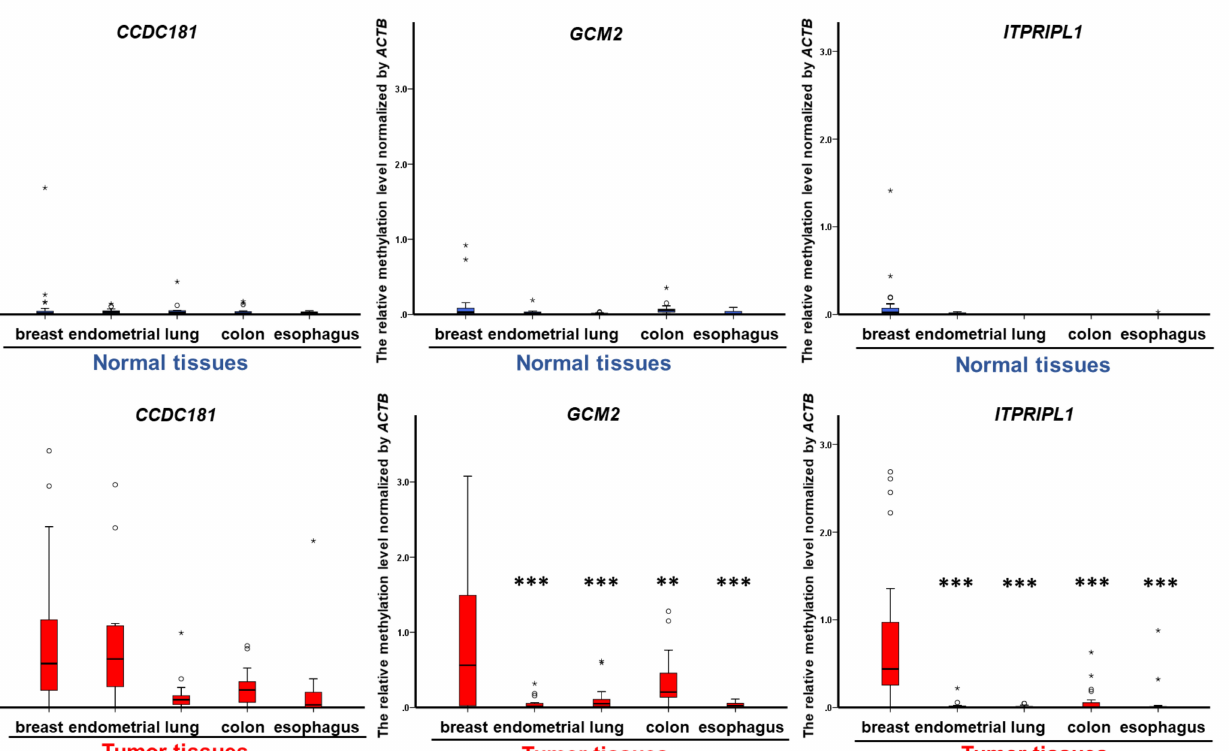
Figure 2. The boxplots for the DNA methylation levels of CCDC181 , GCM2 and ITPRIPL1 in breast cancers and adjacent normal tissues from Taiwanese breast cancer patients. The assays were analyzed by qMSP and included 109 paired breast cancer, 24 paired colon cancer, 16 paired esophageal cancer, 33 paired lung cancer and 15 paired endometrial cancer tissues samples. An independent t -test was used to analyze the differences between breast cancer and other cancers samples. ** p ≤ 0.01 and *** p ≤